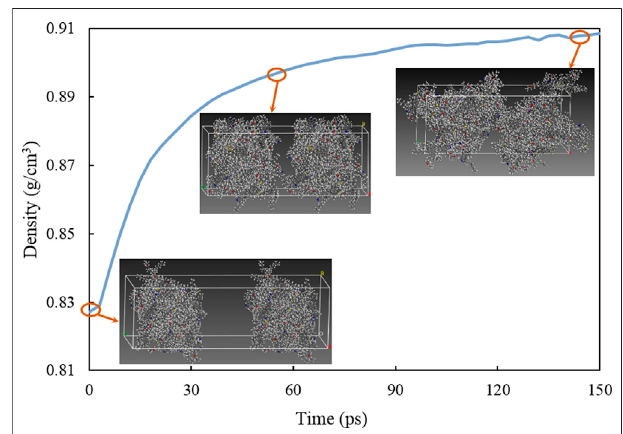
FIGURE3| Densitycurveduringself-healing(PEN70asphaltbinderwith 1.5% CNT1, 55 ° C).